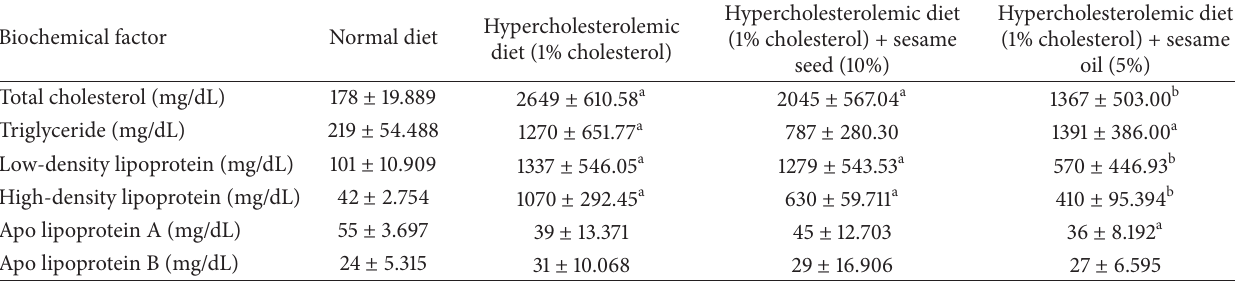
Table 1: Effects of Sesamum indicum on serum concentrations of lipid profile parameters and apolipoprotein in experimental groups. Biochemical factor